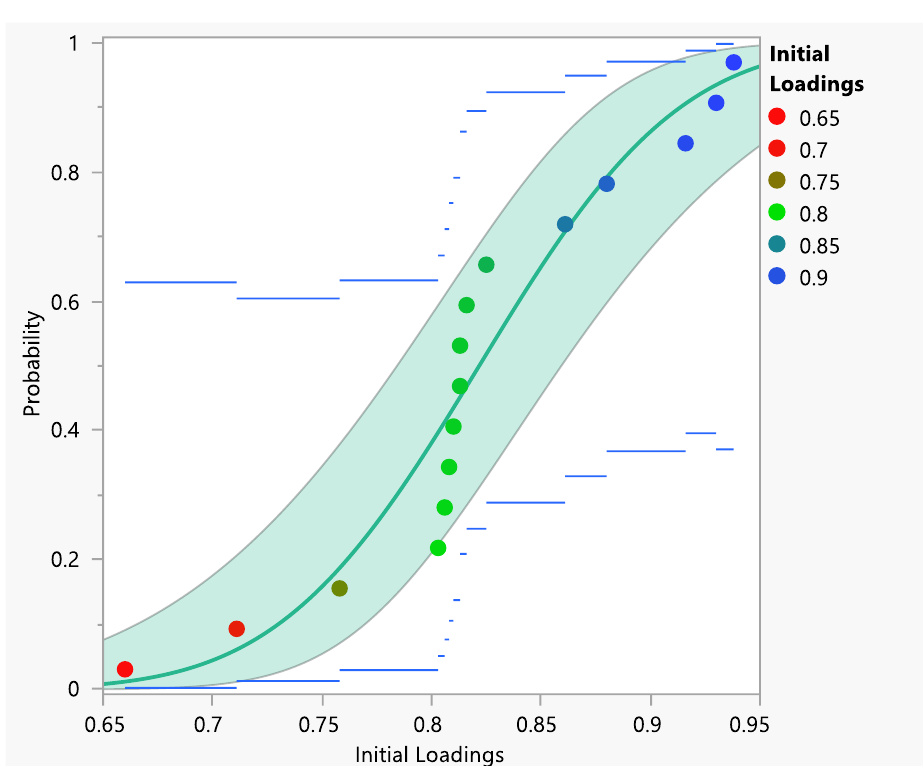
Figure 4. Normal probability curve of item loadings.